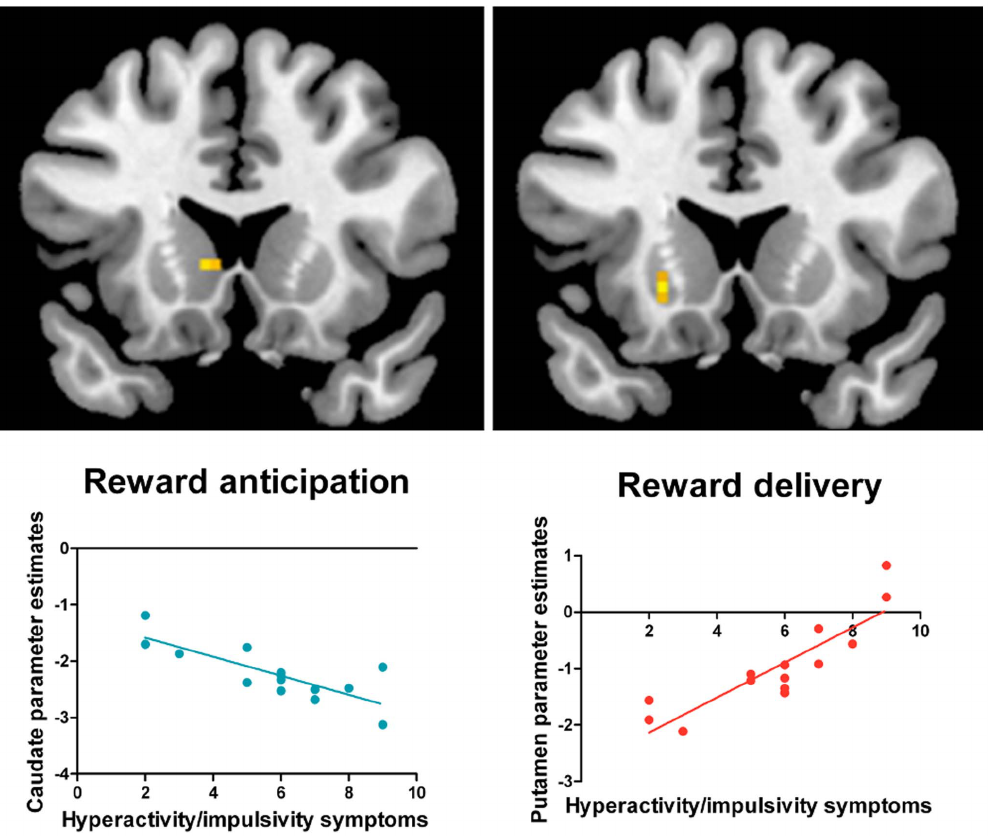
Figure 3. Association between ventral striatal responses and the number of hyperactivity/impulsivity symptoms in the ADHD group. Brain activation displays were generated by overlaying SPM t-maps from the second-level analyses on a MNI standard brain ( p , .005 uncorrected). Reward anticipation (Cue A delay), t=4.25 ( p , .005, uncorrected, MNI local maxima: x, y, z= 2 6, 14, 4); reward delivery (Cue A reward), t=5.43 ( p =.04, FWE corrected, MNI local maxima: x, y, z= 2 21, 20, 2 5). The graphs depict the association between the mean parameter estimates of the peak cluster from the one-sample t-tests (y-axis) and the number of symptoms (x-axis) for each participant in the ADHD group. The graphs are provided for illustrative purposes only, and were not used for statistical inferences. MNI: Montreal Neurological Institute.